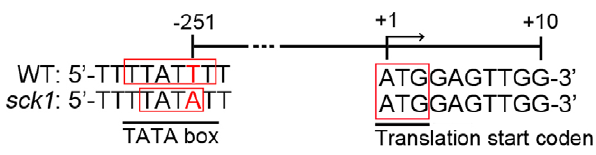
Figure 7. The promoter mutant site of CmKAO in